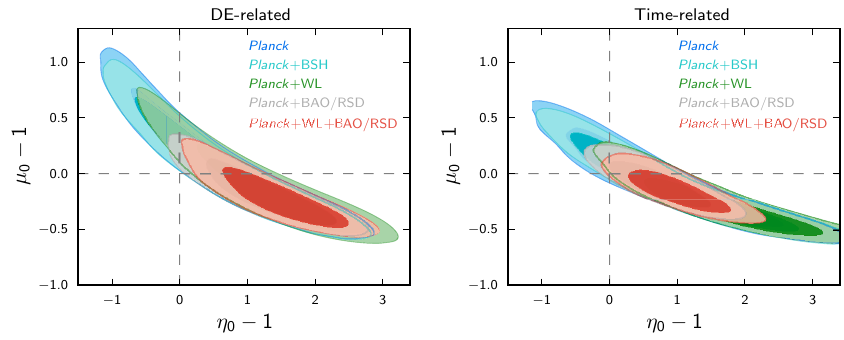
Fig.5 Contour plots for marginalized posterior distributions for 68% and 95% C.L for the two parameters { μ − 1 ,η − 1 } at the present time with no scale dependence. On the left, time dependence is consid- 0 0 ered via the effective dark energy density parameter. On the right panel, time evolution is considered by direct inclusion of the scale factor. Results discussed in text of Sect. 6.1.1. The label Planck stands for Planck TT+TEB. Figure reproduced with permission from Ade et al.